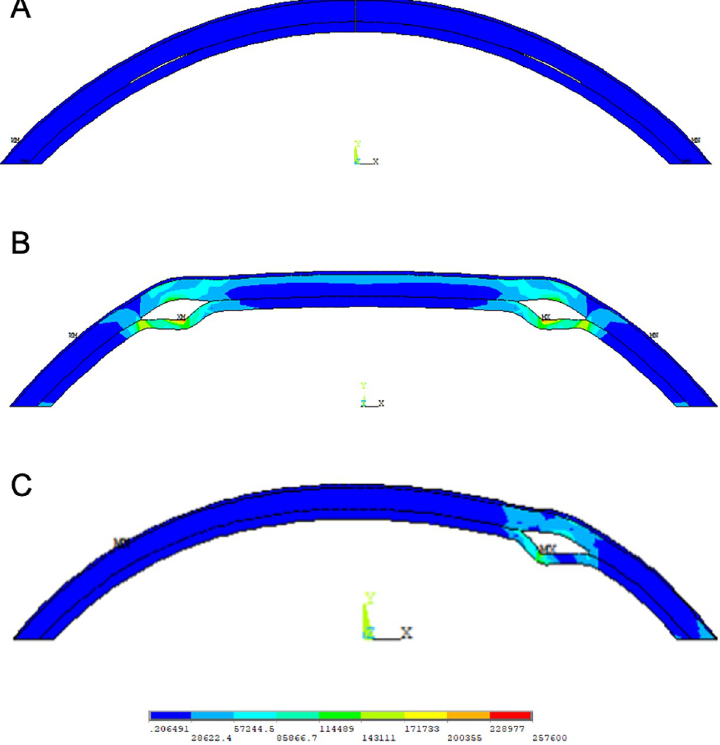
Fig 5. Von Mises stress distribution in the cornea. The results are shown after: IOP application (A), ICRS implantation with a cross-section corresponding to 80˚ of the asymmetric design in the axisymmetric (B) and plane- strain (C)